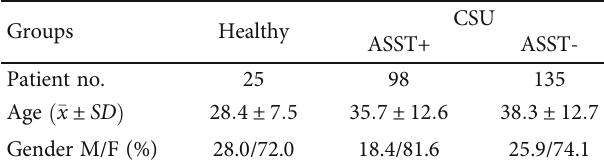
Table 1: Demographic data of volunteers. Groups Healthy